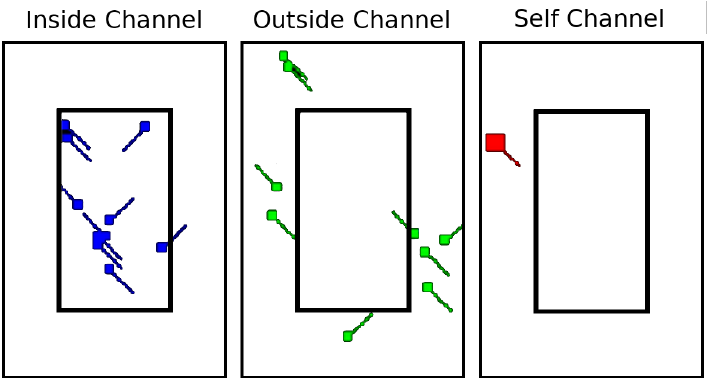
Figure 2. Three channels, image-like, represent the input states of the RL system. The inside and outside channels encode information about the flights. The self-channel encodes information about the agent that is taking action. The inner square represents the shape of the